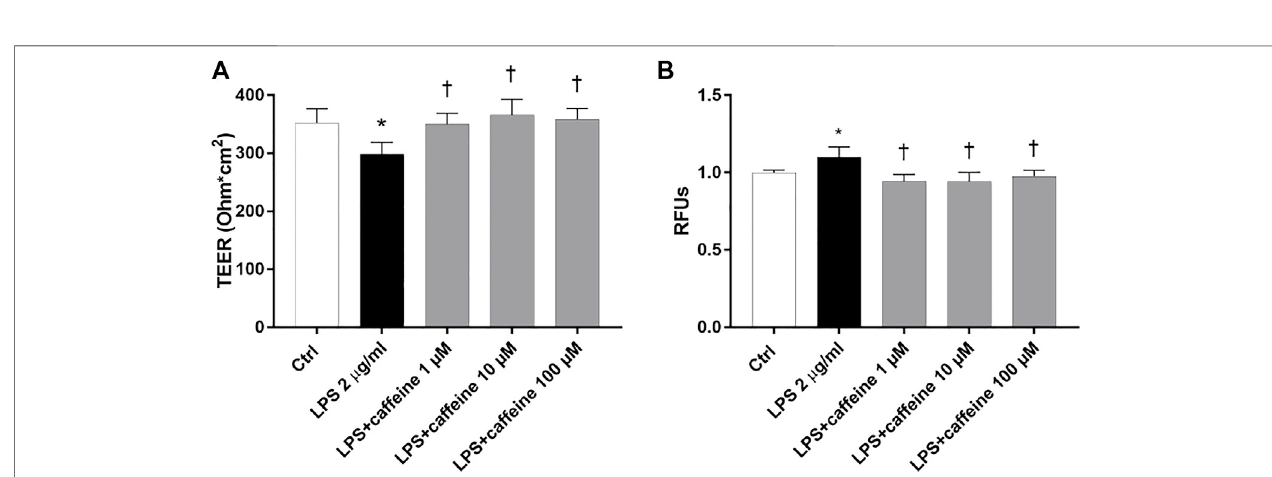
FIGURE 5 | Caffeine protects the ARPE-19 cell monolayer from LPS-induced damage. ARPE-19 were pretreated with caffeine (1 – 10 – 100 µM) for 24 h and co- treatedwithLPS(2 µ/ml)for24 h (A) Caffeine,at allconcentrations,increasedTEER values,whichwerereducedbyLPS (B) Measurementofapical-to-basolateralNa-F permeability.RepresentativeNa-Fpermeabilitymeasuredafter15 min.Valuesarereportedasmean ± SD; n (cid:1) 4.Datawereanalyzedbyone-wayANOVAandtheTukey post hoc test for multiple comparisons. * p < 0.05 vs. control; † p < 0.05 vs. LPS 2 μ g/ml; ‡ p < 0.05 vs. LPS + caffeine 100 µM.